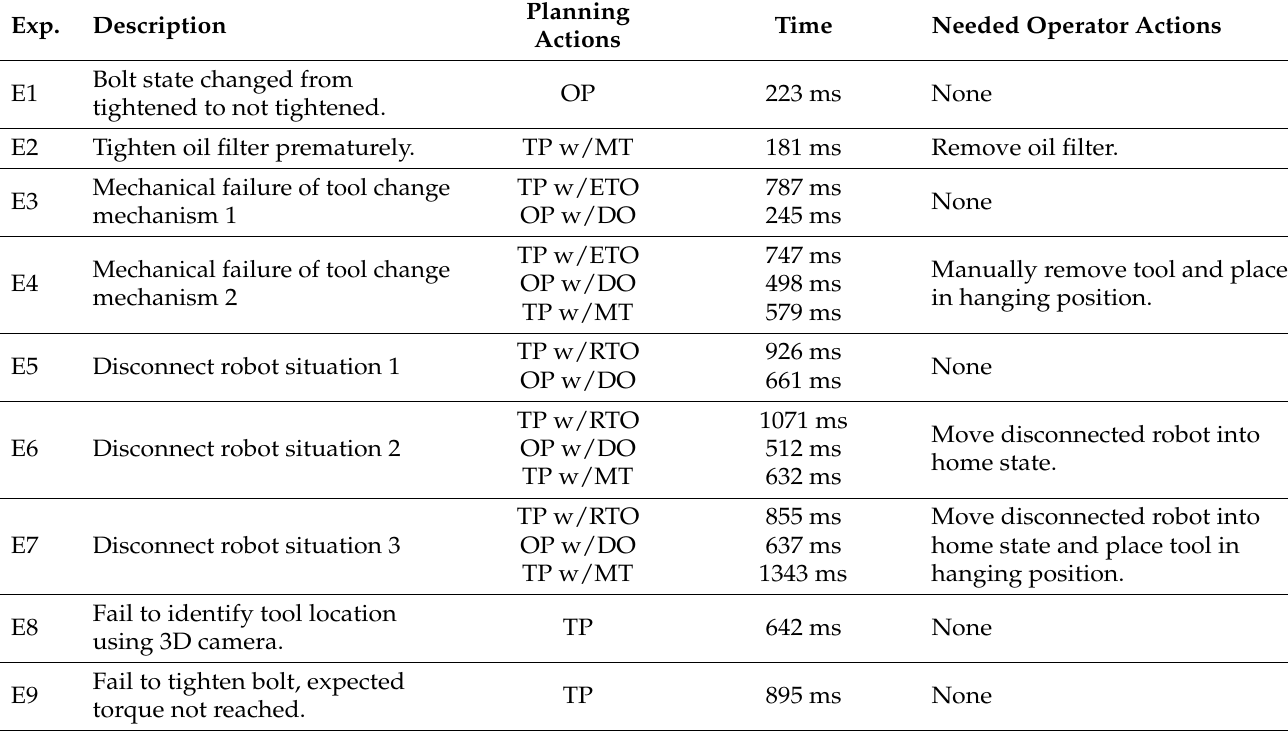
Table 1. Experiments with error